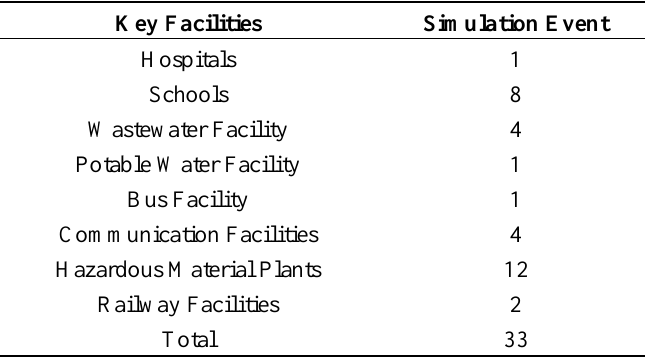
Table 2. Affected key